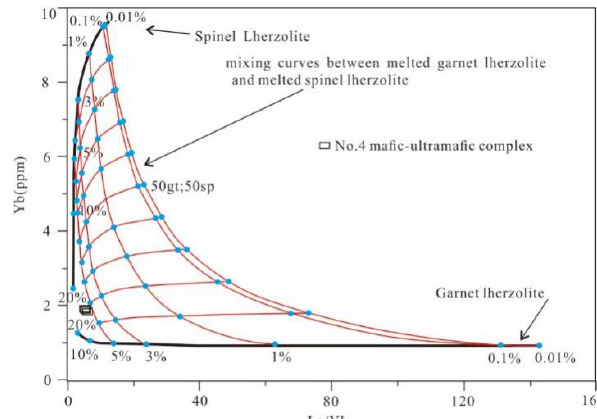
Figure 12. Plot of Yb vs. La/Yb for the Akechukesai Ⅳ mafic–ultramafic complex. Non-modal batch melting curves were calculated by using partition coefficients from McKenzie and O'Nions [58], Rollinson [59] and Keskin [60].